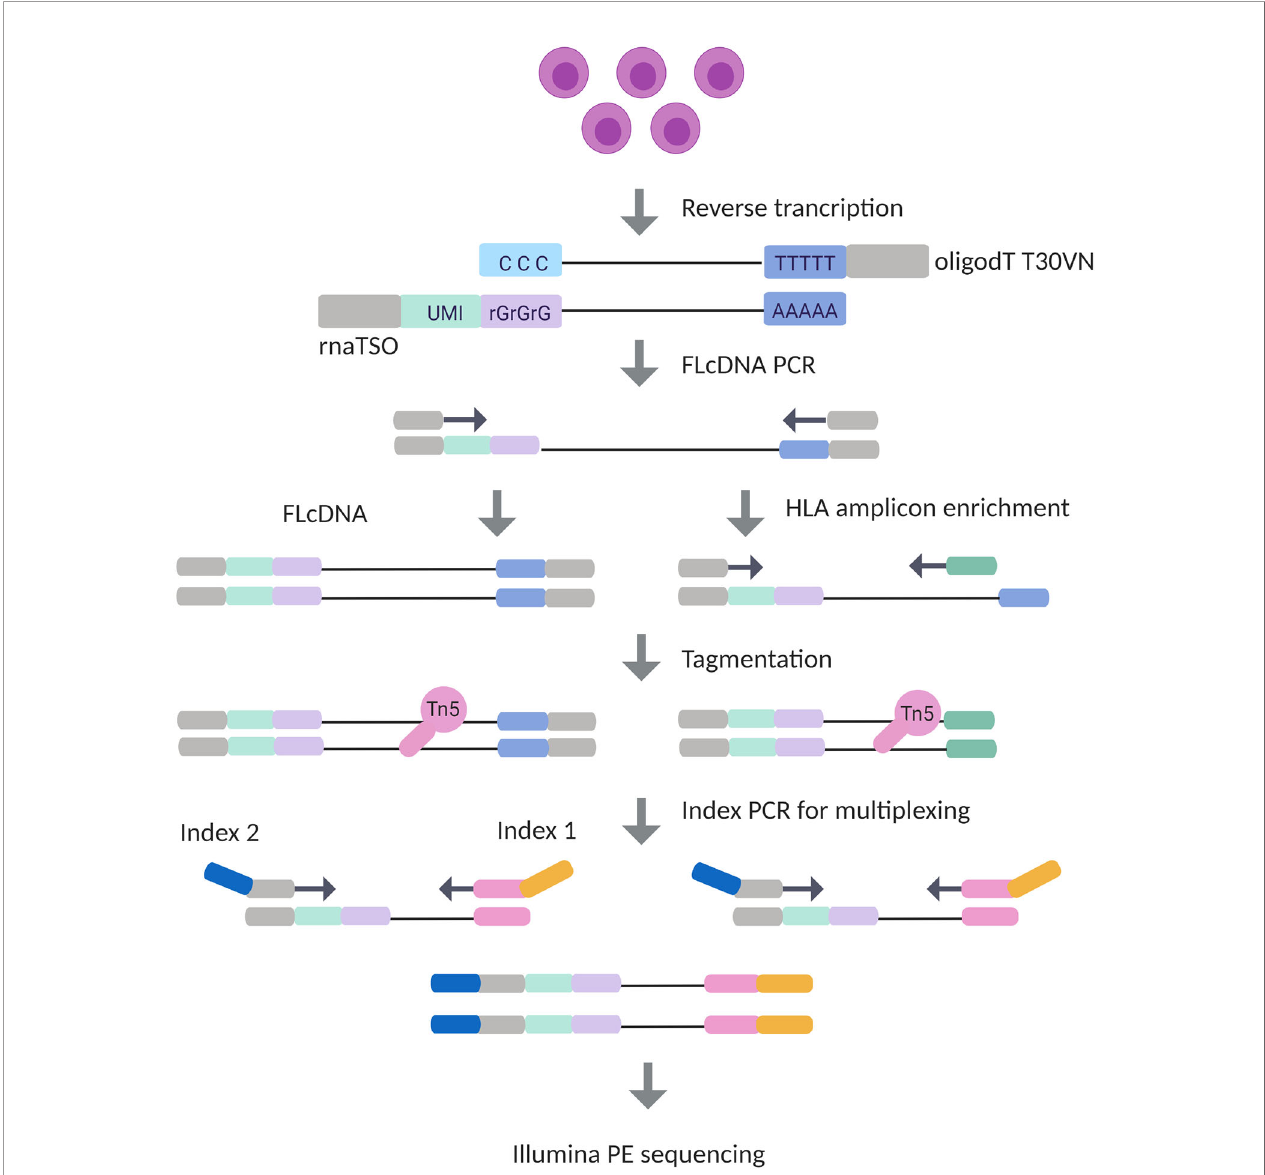
FIGURE 1 | Experimental design of Illumina HLA RNA-Seq. In the library preparation process, mRNA is fi rst transcribed into complementary DNA (cDNA) with simultaneous integration of 10 bp unique molecular identi fi er (UMI) in RNA template switching oligo (rnaTSO) and further ampli fi ed. The full-length cDNA (FLcDNA) is then divided and processed in parallel in Illumina ’ s cDNA and amplicon library preparation protocols. The amplicon library preparation included an enrichment of HLA genes using gene-speci fi c primers. Lastly, the full-length cDNA and HLA amplicons are tagmented, and sample-speci fi c barcodes are added for multiplexing. The method results 5 ’ end library molecules suitable for Illumina paired-end